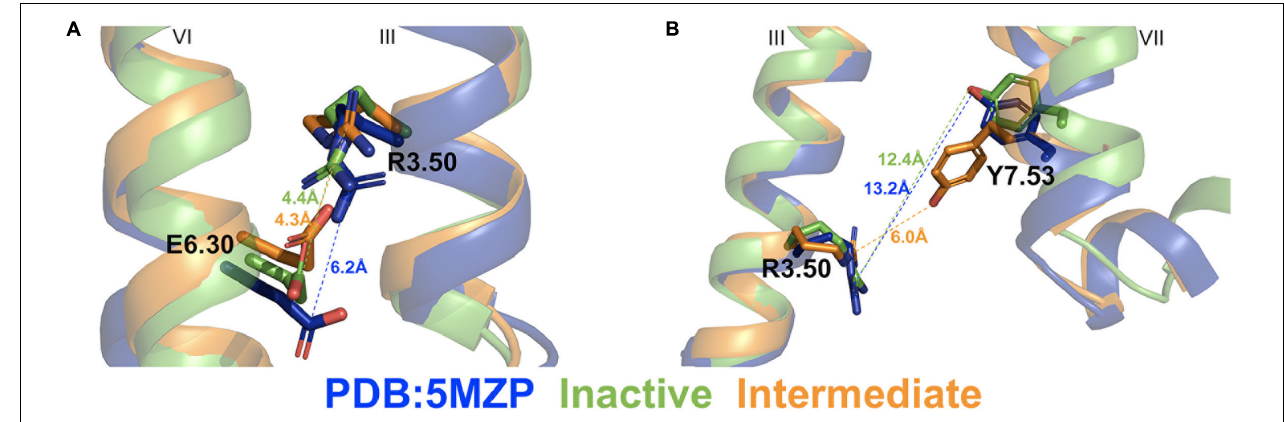
FIGURE 4 | Representative “inactive” (green) and “intermediate” (orange) low-energy conformations of the A 2A AR compared with the 5MZP PDB structure (blue). (A) The ionic lock distance between charge centers of residues R3.50 and E6.30 in the 5MZP, inactive, and intermediate conformations are 6.0, 4.4, and 4.3 Å, respectively. (B) The distance between atom CZ in residue R3.50 and hydroxyl oxygen atom of Y7.53 in the 5MZP, inactive, and intermediate conformations are 13.2, 12.4, and 6.0 Å,